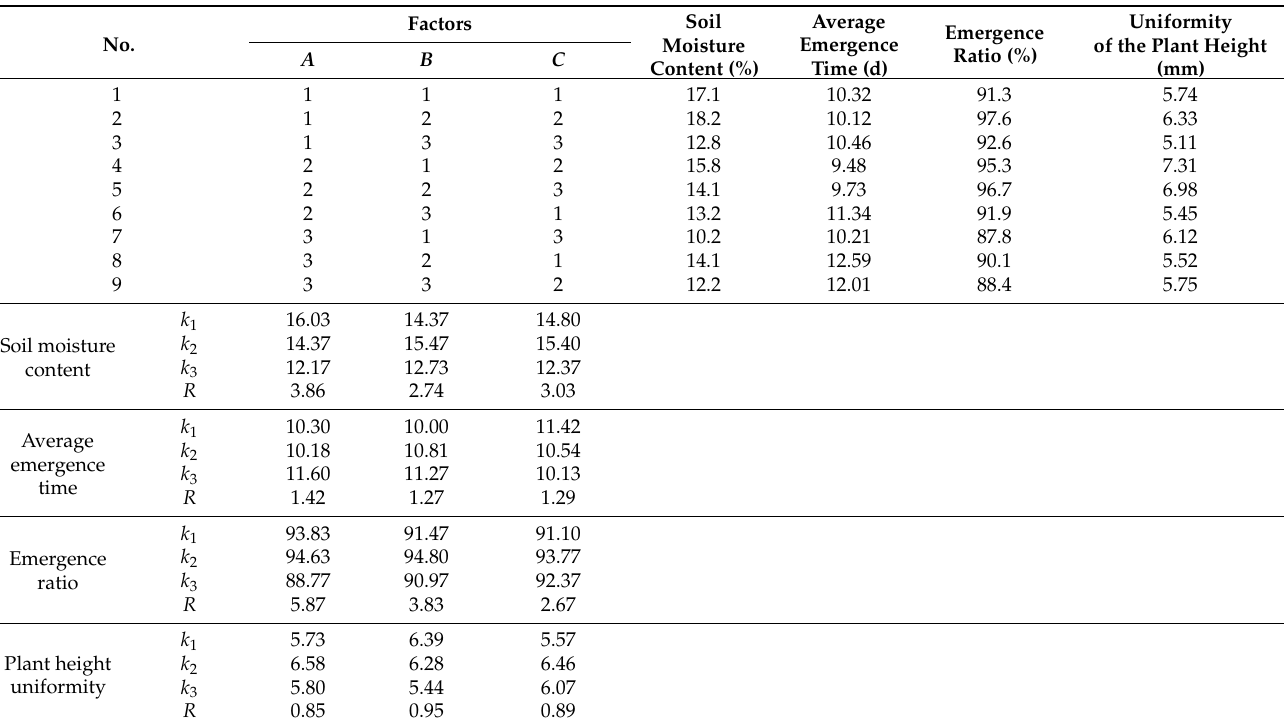
Table 3. Results of the orthography experiment and range analysis.